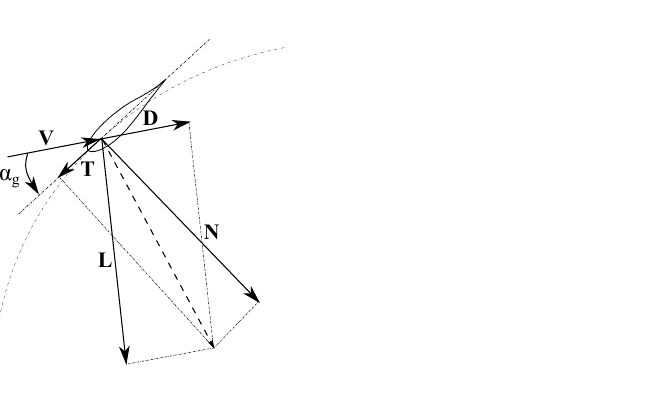
Figure 3. Aerodynamic forces on a VAWT blade cross section.